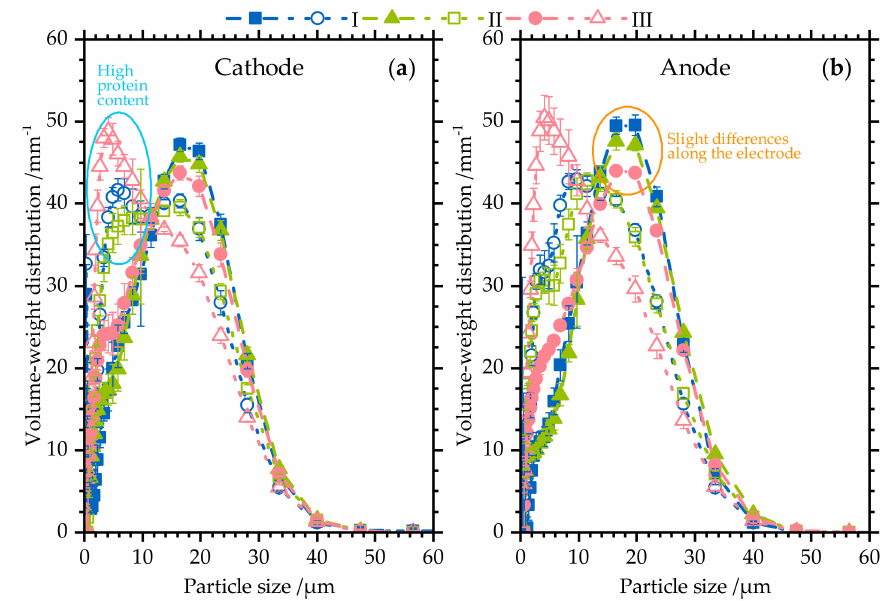
Figure 3. Volume–weight density distributions recorded near the cathode ( a ) and the anode ( b ) in regions I, II, and III. Closed and open symbols denote initial protein contents of 15 and 30 wt %, respectively. Increasing the initial protein content reduces the particle size at both anode and cathode. The particle size distributions di ff er in the three measuring